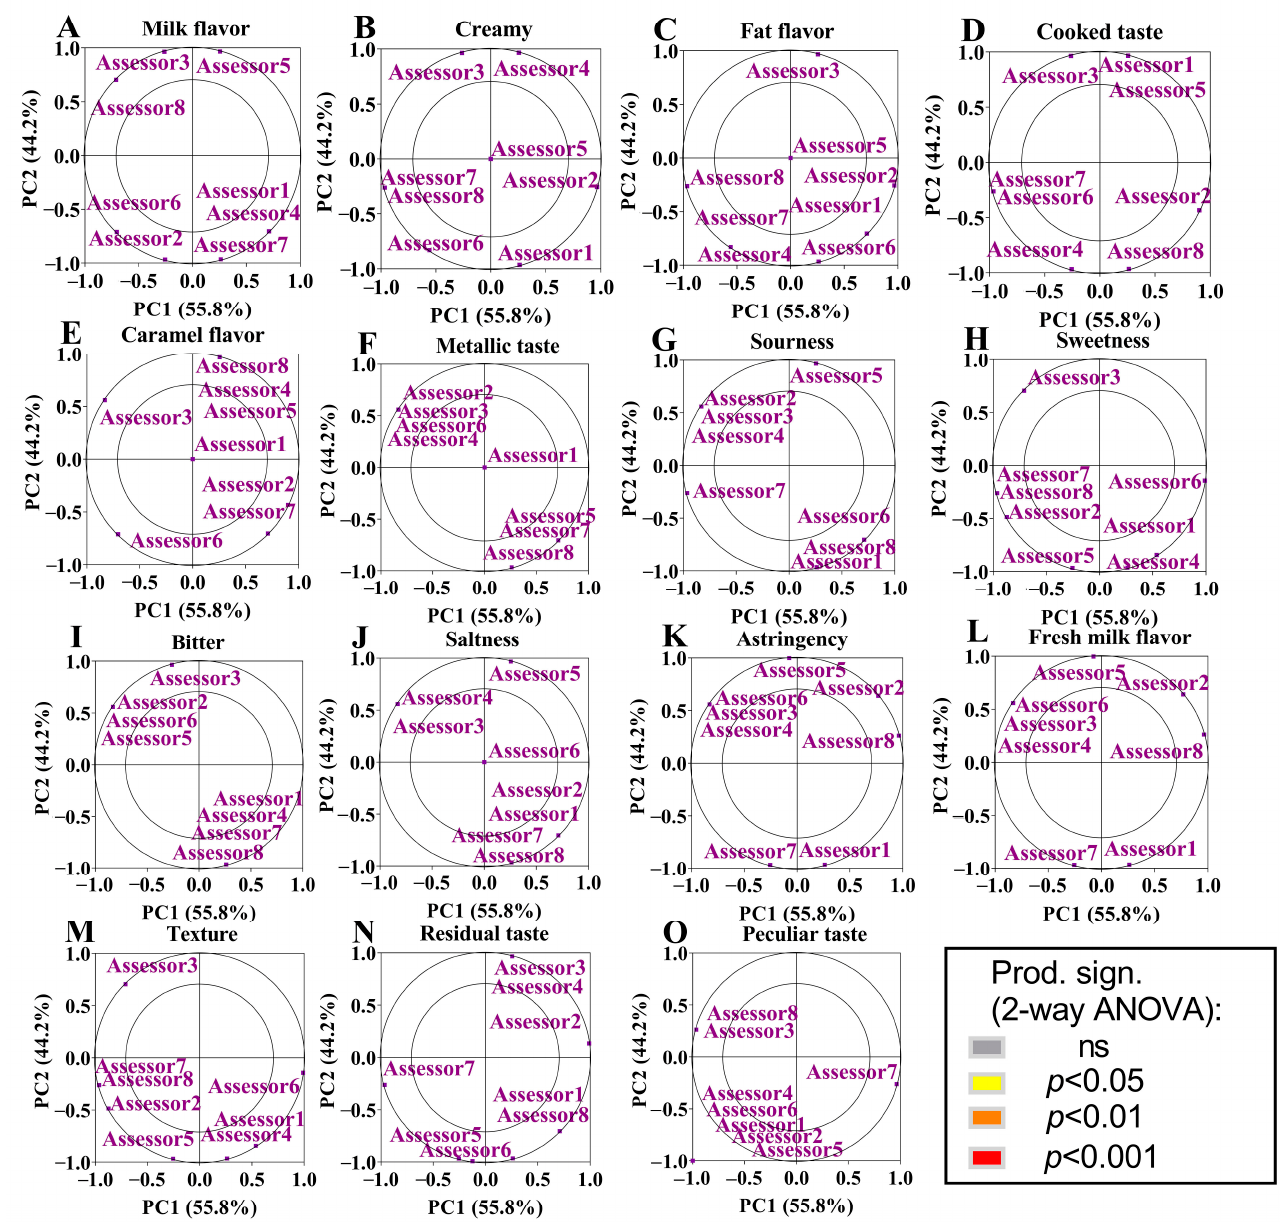
Figure 2. Checking the consistency of sensory evaluation group using Tucker-1 analysis for milk samples stored for 72 h. There were eight assessors and 15 flavors in total. ( A ) Milk flavor; ( B ) Creamy; ( C ) Fat flavor; ( D ) Cooked taste; ( E ) Caramel flavor; ( F ) Metallic taste; ( G ) Sourness; ( H ) Sweetness; ( I ) Bitter; ( J ) Saltness; ( K ) Astringency; ( L ) Fresh milk flavor; ( M ) Texture; ( N ) Residual taste; ( O ) Peculiar taste. A p < 0.05 was considered statistically significant.